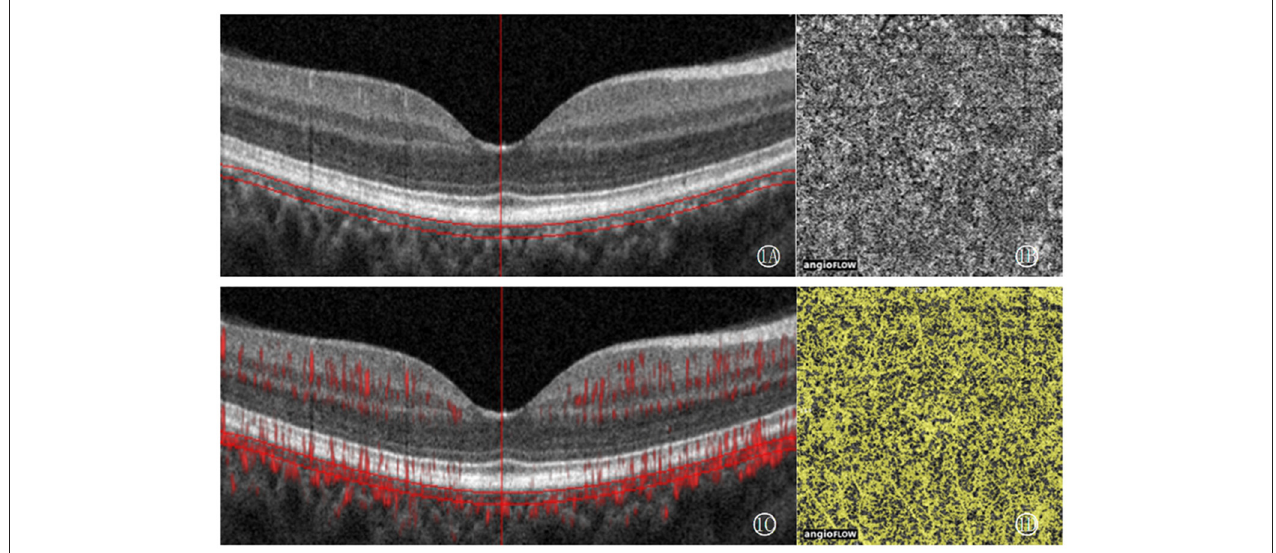
FIGURE 1 | CCD measurement figures: select the choroidal capillary layer, use OCTA vascular quantification 2.0 software to measure the density of the choroidal capillary layer in 3 × 3mm mode, that is, the total area of blood flow divided by the total area of the layer (9 mm 2 ) × 100%. (1A) shows the defined measurement level, between the parallel lines is the choroidal capillary layer, the vertical line is the macular fovea position calibration line, (1B) shows the en-face image, and (1C) shows the blood flow signal acquisition image. (1D) shows the blood flow pixel image.